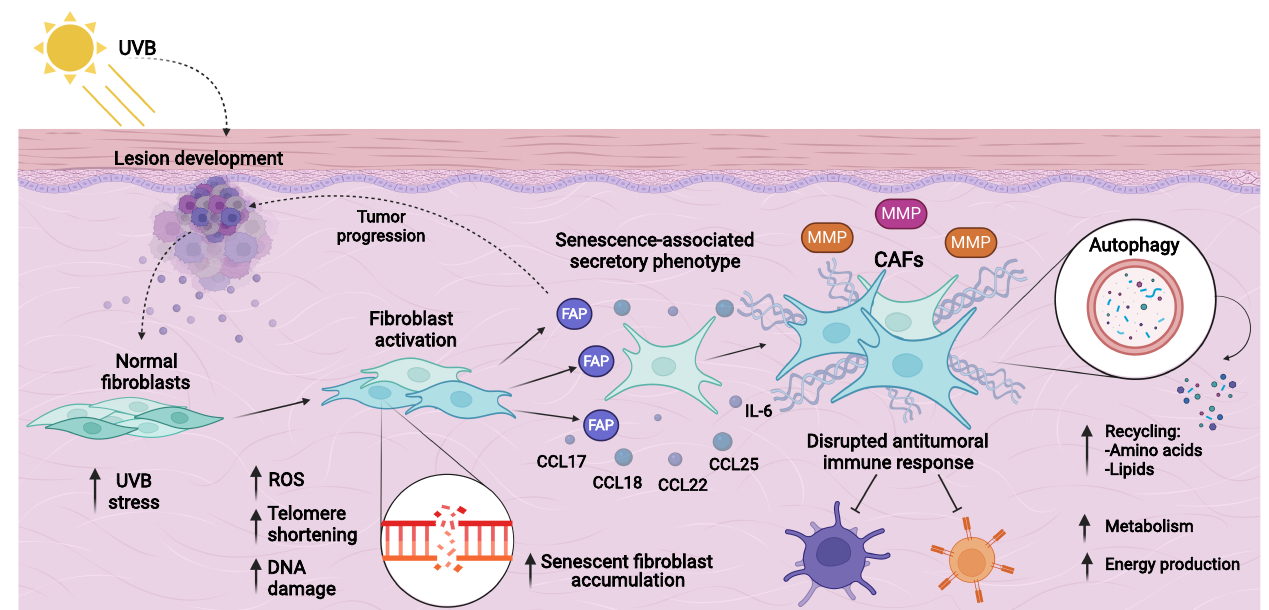
Figure 3. Fibroblast transformation to cancer-associated fibroblasts (CAFs) and their implication in the tumor microenvironment. Several elements and sequential phases are involved in the activation and transformation of fibroblasts into CAFs. CAFs acquire a distinct phenotype denominated as the senescence-associated secretory phenotype (SASP), which favors the accumulation of senescent cells. Fibroblast activation protein (FAP) is a key marker of fibroblast activation. Higher expression of matrix metallopeptidases promotes the establishment and progression of neoplasms, through extracellular matrix degradation, as previously mentioned. DNA damage due to UVB radiation is also a cause of fibroblast DNA integrity disruption, telomere shortening, and reactive oxygen species (ROS) production. Altered expression of immune system molecules, such as cytokines and chemokines, can interrupt the local antitumoral response and maintain this CAF activation process. In addition, autophagy produces amino acids and lipids fragments that provide energy sources to preserve an indispensable activated metabolism for cell transformation and migration. The present figure was created with BioRender.com, accessed on 4 May 2022. All icons, templates, and other original artwork appearing in the attached completed graphic are pursuant to BioRender’s Academic License